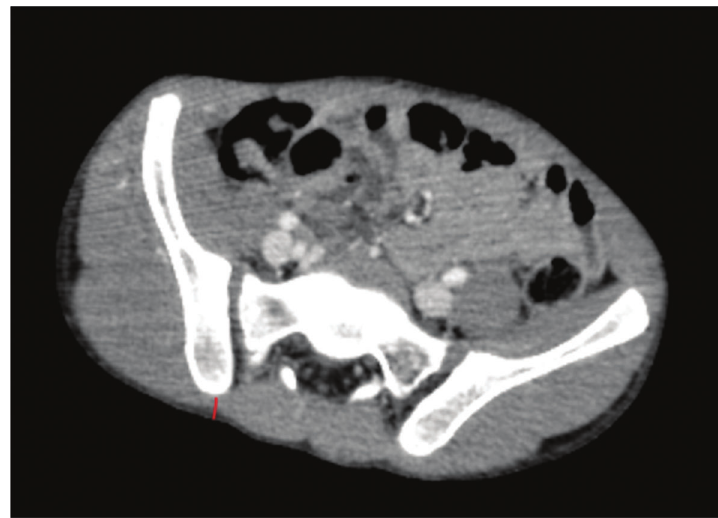
Figure 3 - Example of distance from skin iliac screw measurement (shown by red line).